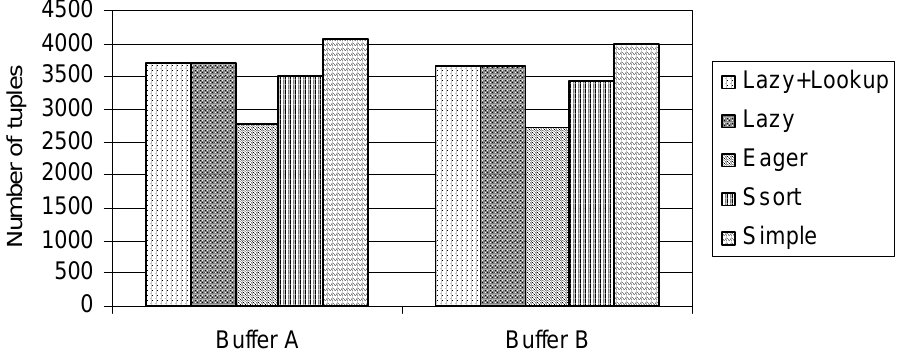
Figure 5. Average lengths of stream